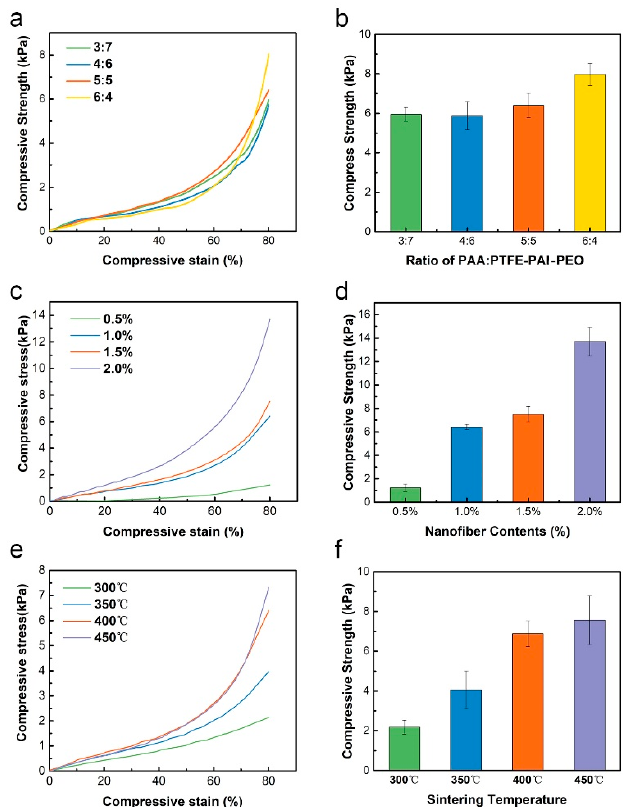
Figure 8. The compressive stress–strain curves and compressive strength at 80% of PI/PTFE–PAI NAs. ( a , b ) NAs of different weight ratio; ( c , d ) NAs with different solid contents; ( e , f ) NAs sintered at different temperatures.